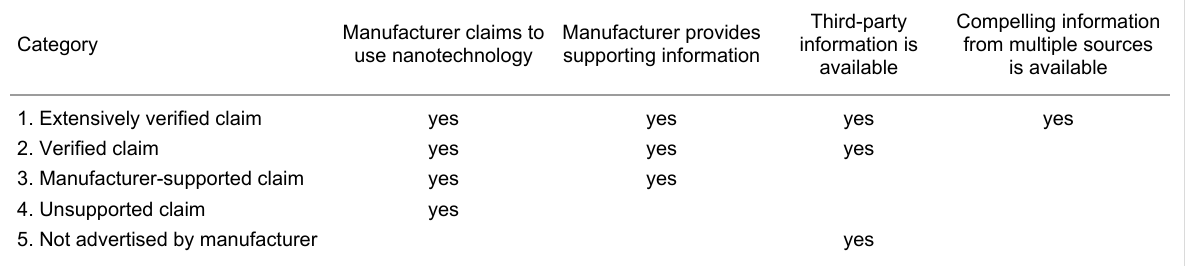
Table 2: “How much we know” categorization, based on the information available to substantiate manufacturer claims that a particular product contains nanomaterial components. Category